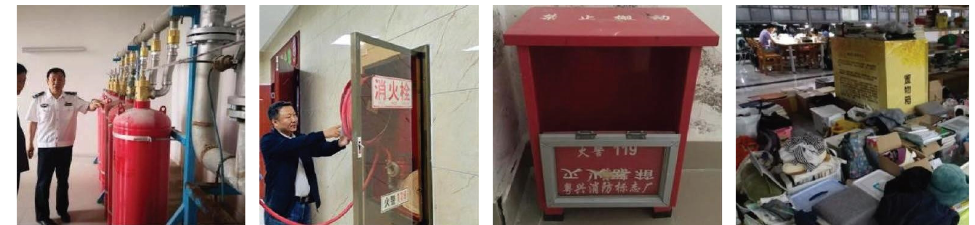
Figure 5: Survey